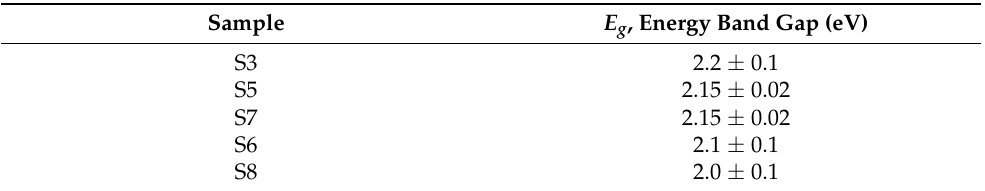
Table 5. Bandgap values of different